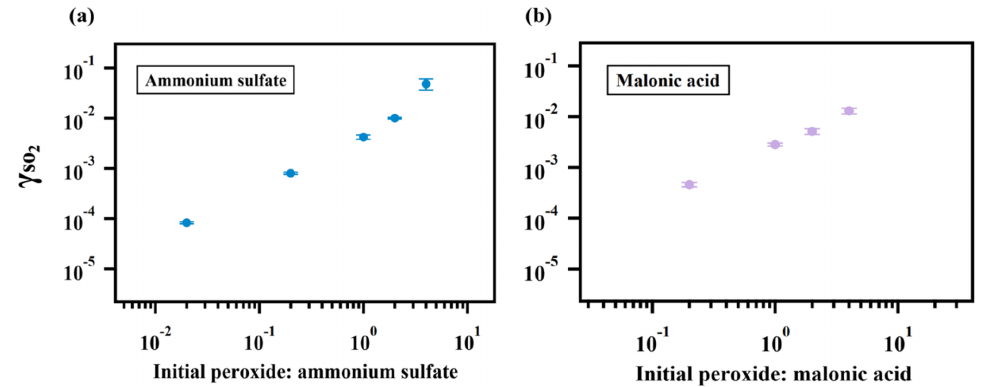
Figure 3. Relationship between γ SO values for ammonium sulfate (a) and malonic acid aerosol (b) and particulate peroxide content. γ SO 2 2 on the amount of peroxide injected containing different amounts of 2-butanone peroxide are shown here. The observed dependence of γ SO 2 is linear since the slopes of the relationship are both nearly 1 in (a) and (b)